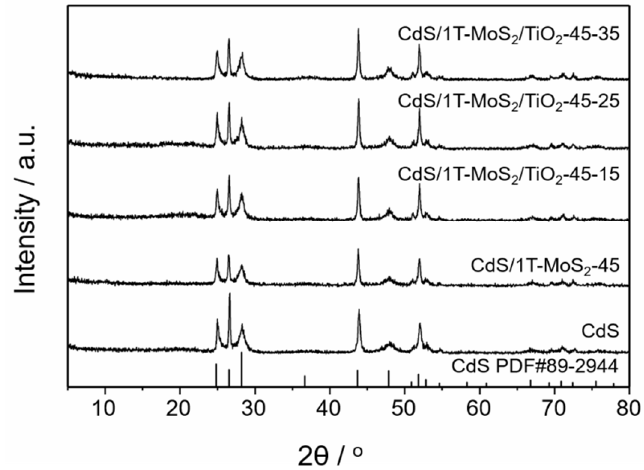
Figure 1. XRD patterns of the bare CdS, binary CdS/1T-MoS 2 , and ternary CdS/1T-MoS 2 /TiO 2 het- erojunctions.